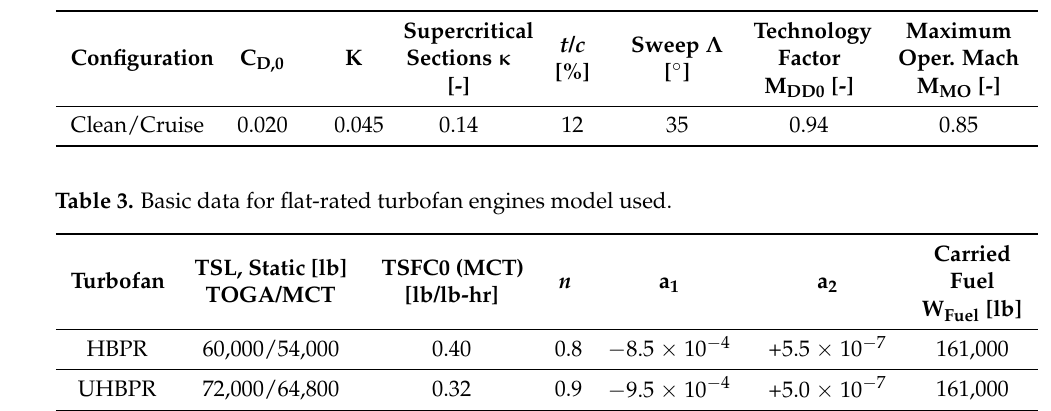
Table 2. Aerodynamic data of the fictitious large T-category FAR/CS 25 commercial jet.